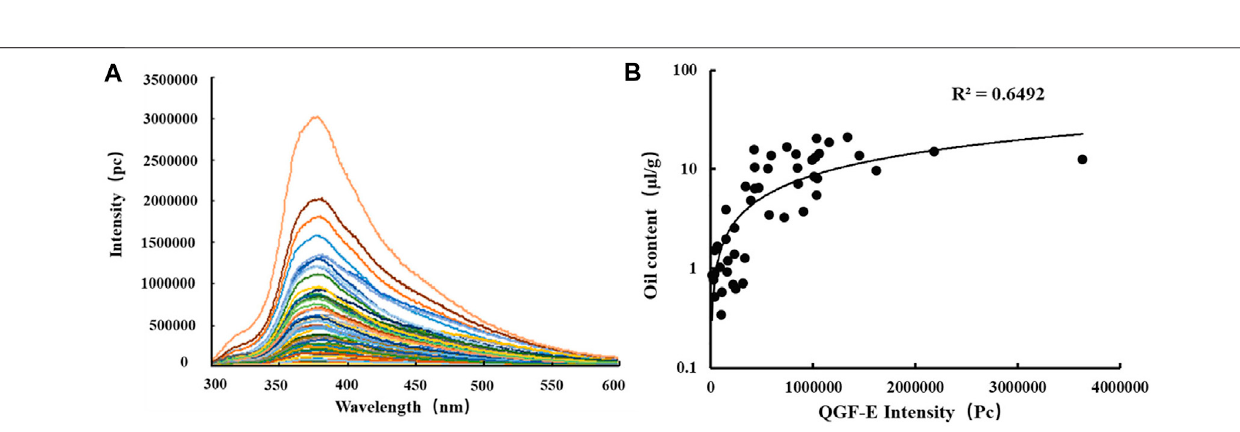
Frontiers in Earth Science |